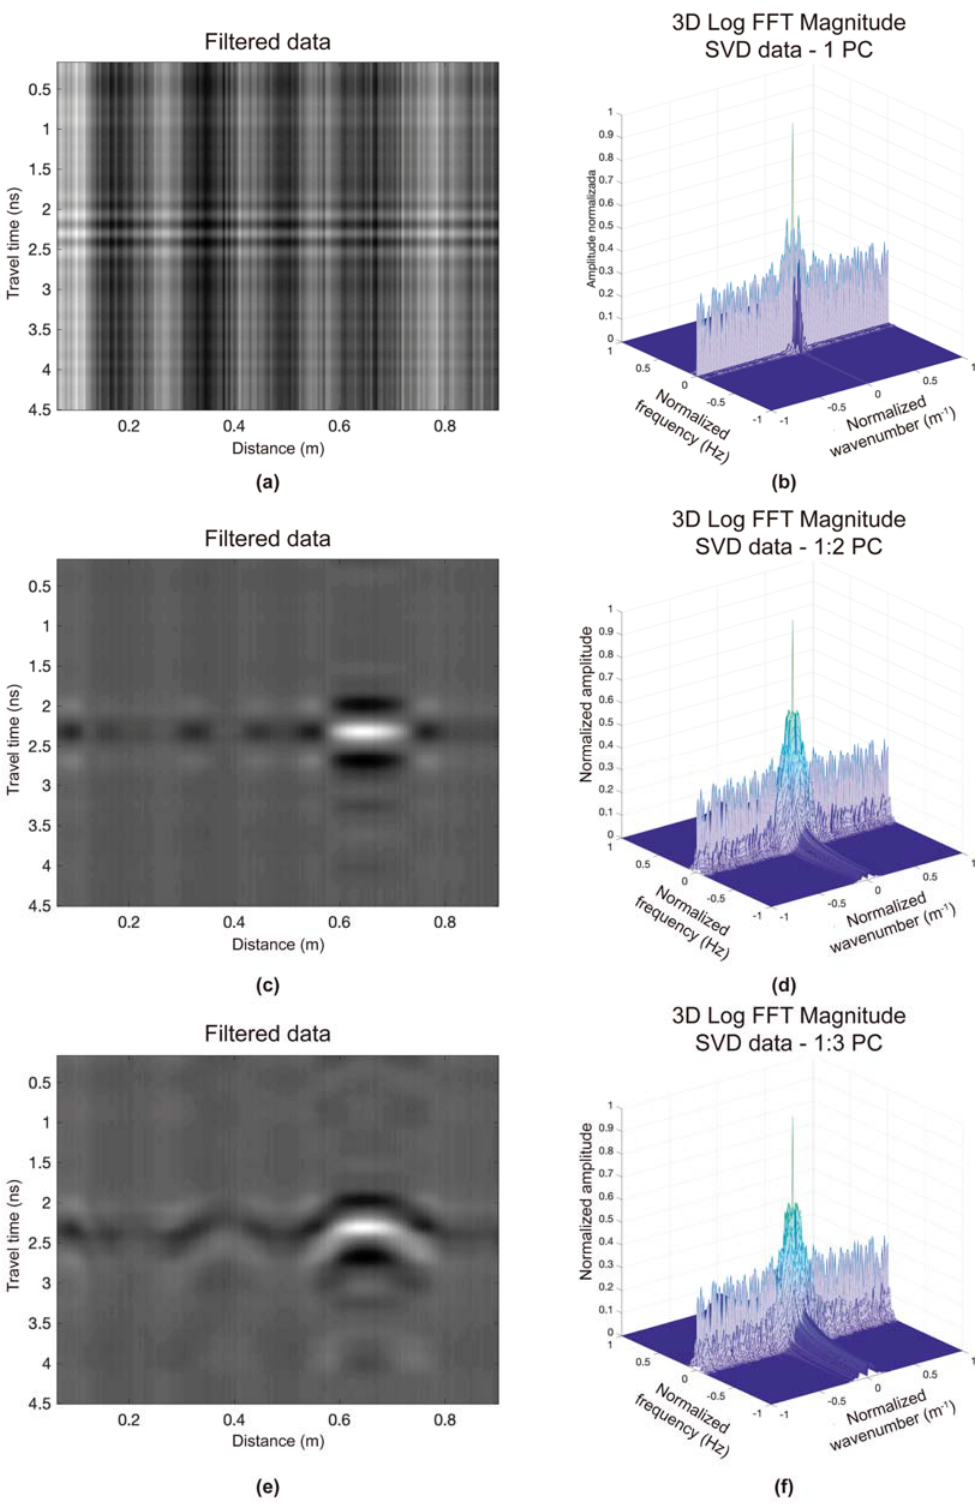
Figure 7. Results of the performed tests to verify the effect of the data restoration and its magnitude spectra considering only some principal components. ( a , b ) Filtered data keeping only the first principal component. ( c , d ) Filtered data keeping the first two principal components. ( e , f ) Filtered data keeping the first three principal components.